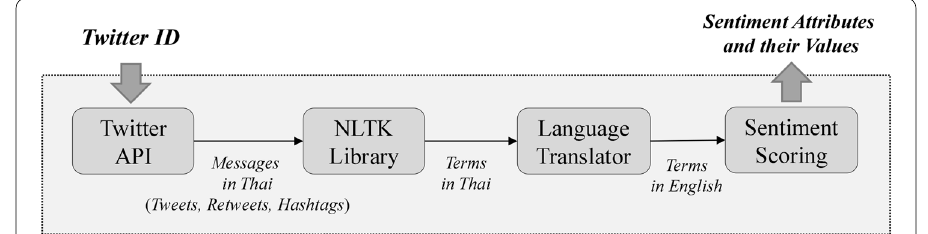
Fig. 3 The process of feature